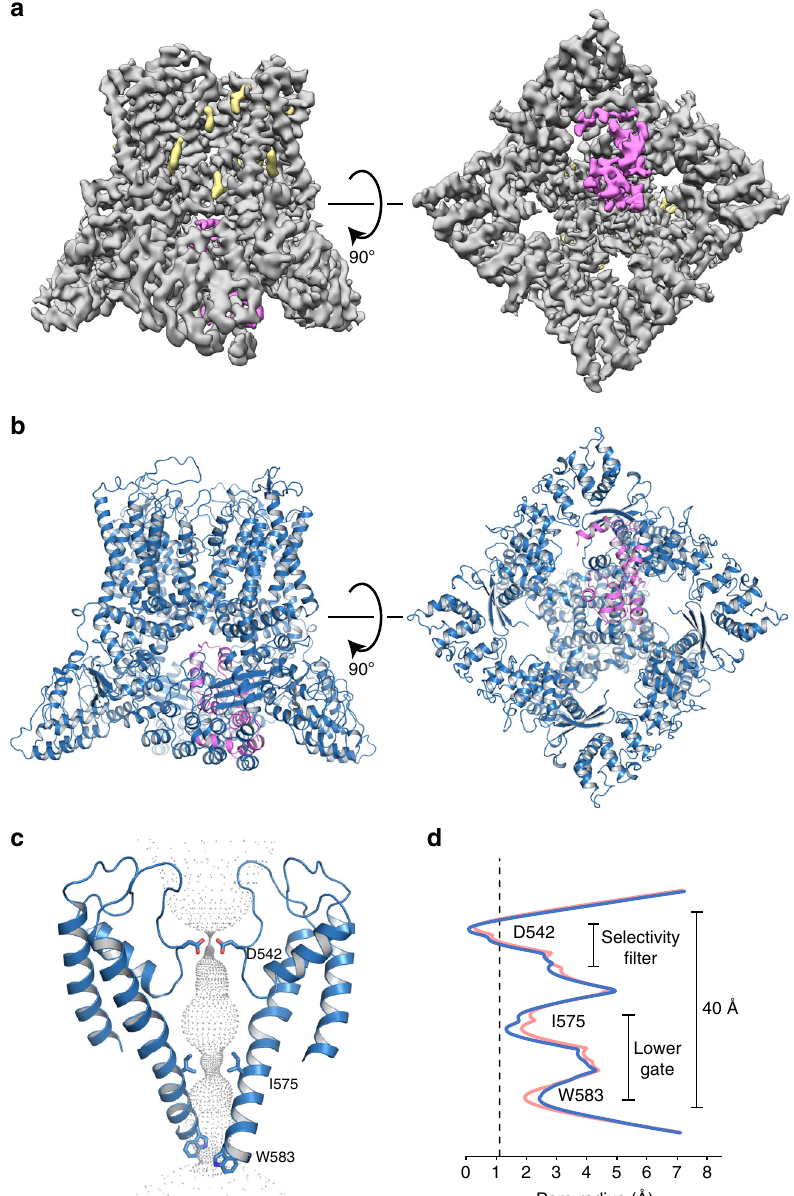
Fig. 5 CaM-bound structure of TRPV5. a Side and bottom view of the CaM-bound TRPV5 density map at 4.4 Å resolution. Density for TRPV5 is shown in gray, annular lipids shown in khaki, and CaM shown in hot pink. b Cartoon representation of the CaM-bound TRPV5 model in a side and bottom view. TRPV5 is shown in blue and CaM is shown in hot pink. c Pore diagram of CaM-bound TRPV5. Constriction residues are labeled and shown as sticks. d Plot of pore radii of CaM-bound TRPV5 as a function of distance through the pore is shown in blue. For reference, the lipid-bound TRPV5 pore graph is shown in pink. The dotted line indicates the radius of a calcium